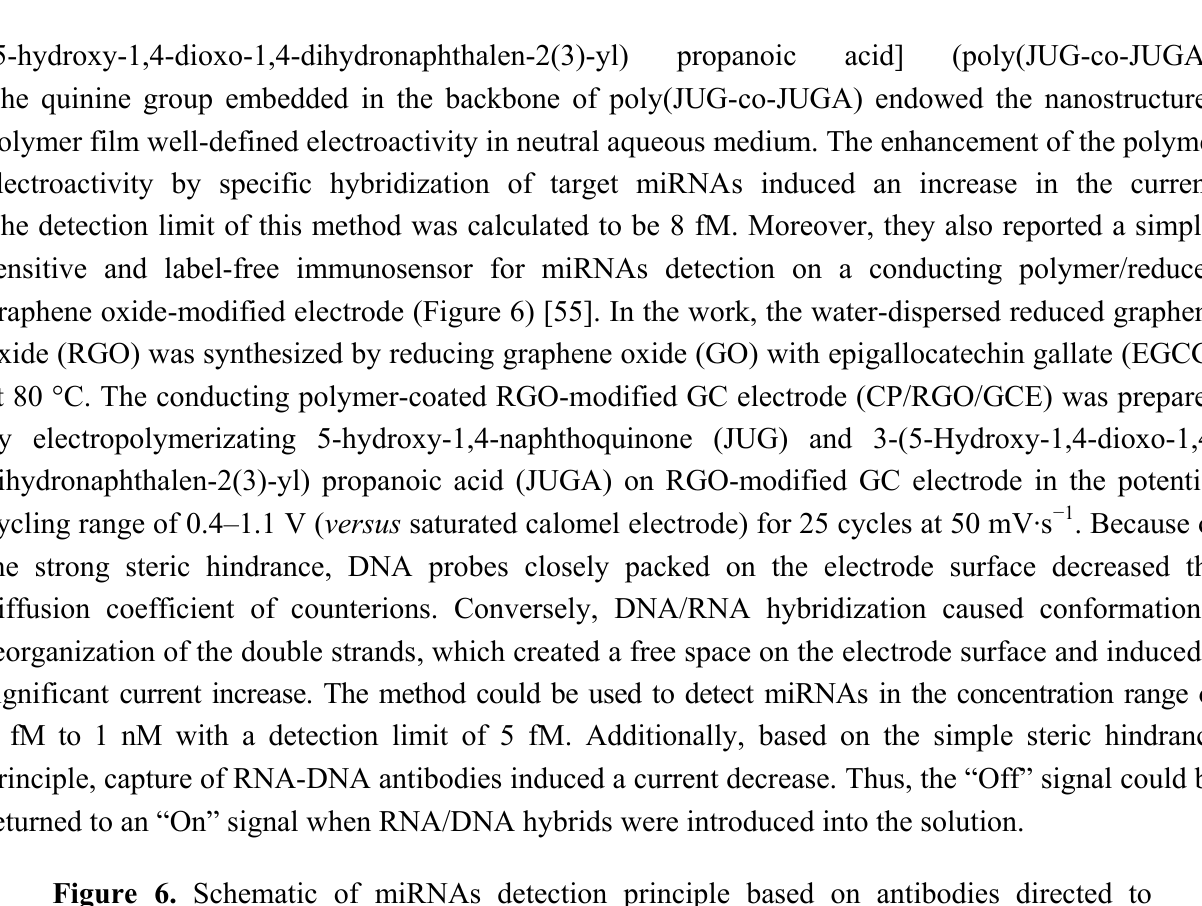
Figure 6. Schematic of miRNAs detection principle based on antibodies directed to RNA/DNA hybrids using graphene-composite electrodes. Reprinted with permission from [55]. Copyright 2013 American Chemical Society.